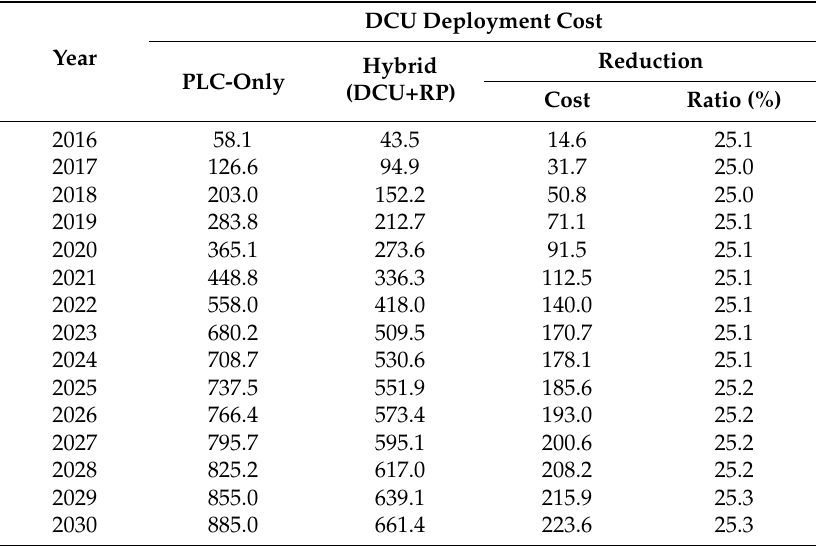
Table 7. Comparison of DCU Cost Result per Deployment Method.